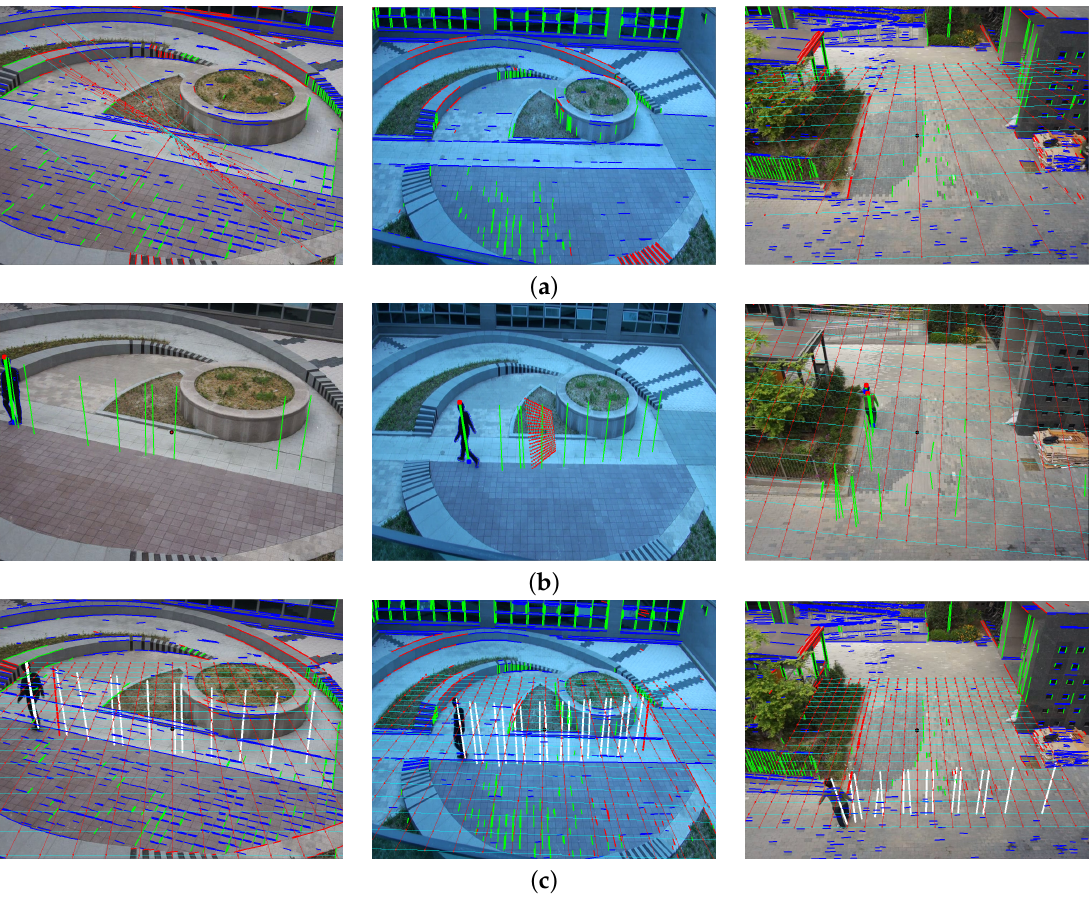
Figure 7. Results of three different method for camera calibration: ( a ) background structure-based method; ( b ) moving object-based method; and ( c ) the proposed camera calibration method.